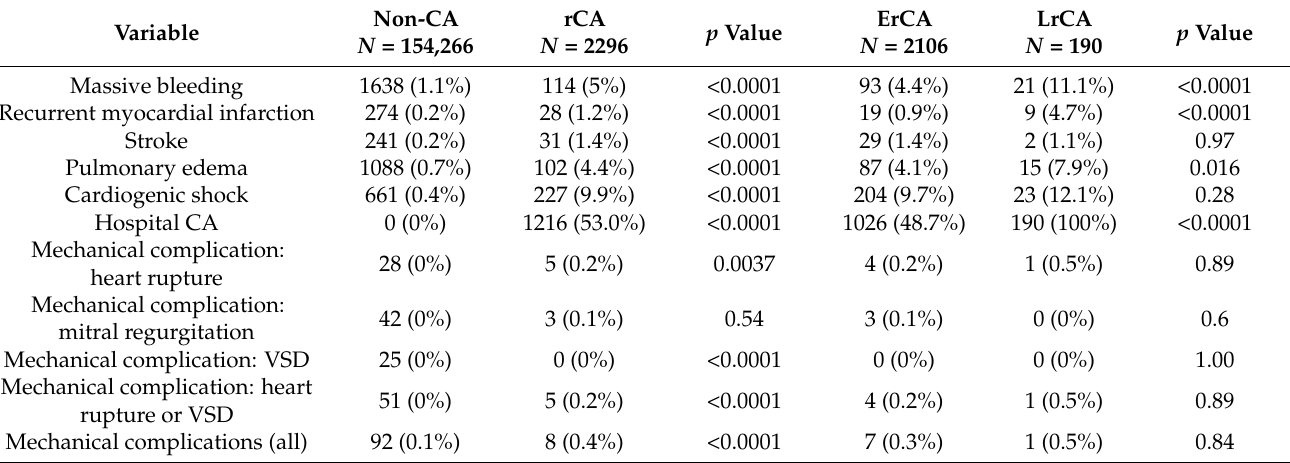
Table 3. In-hospital complications of patients without cardiac arrest and with ErCA and LrCA after acute myocardial infarction (only patients who were discharged after index hospitalisation).